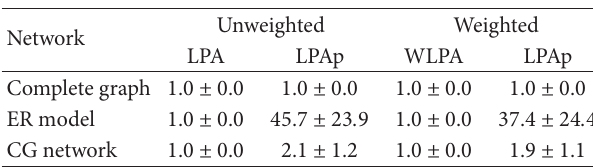
Table 1: The numbers of communities obtained by LPA, WLPA, and LPAp on three kinds of